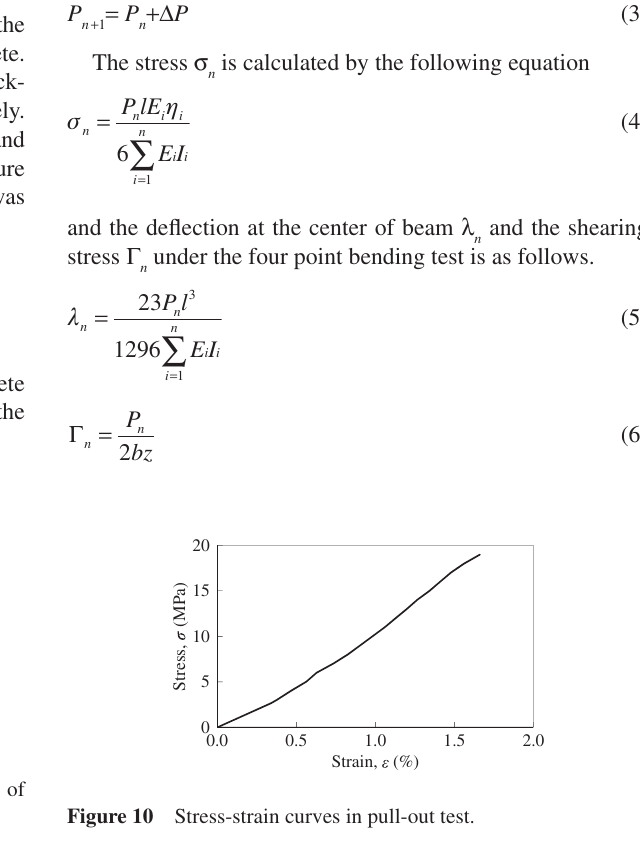
Figure 7 Relation of bending strength to absorbed energy.